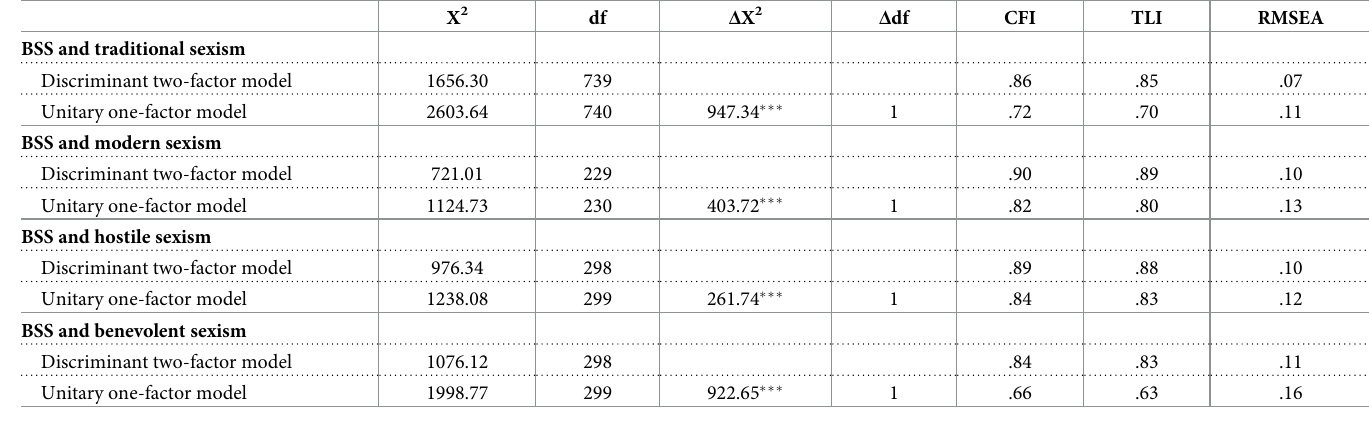
Table 6. Discriminant validity of the BSS scale compared to other sexism scales (traditional sexism, modern sexism, hostile sexism, and benevolent sexism). Χ 2